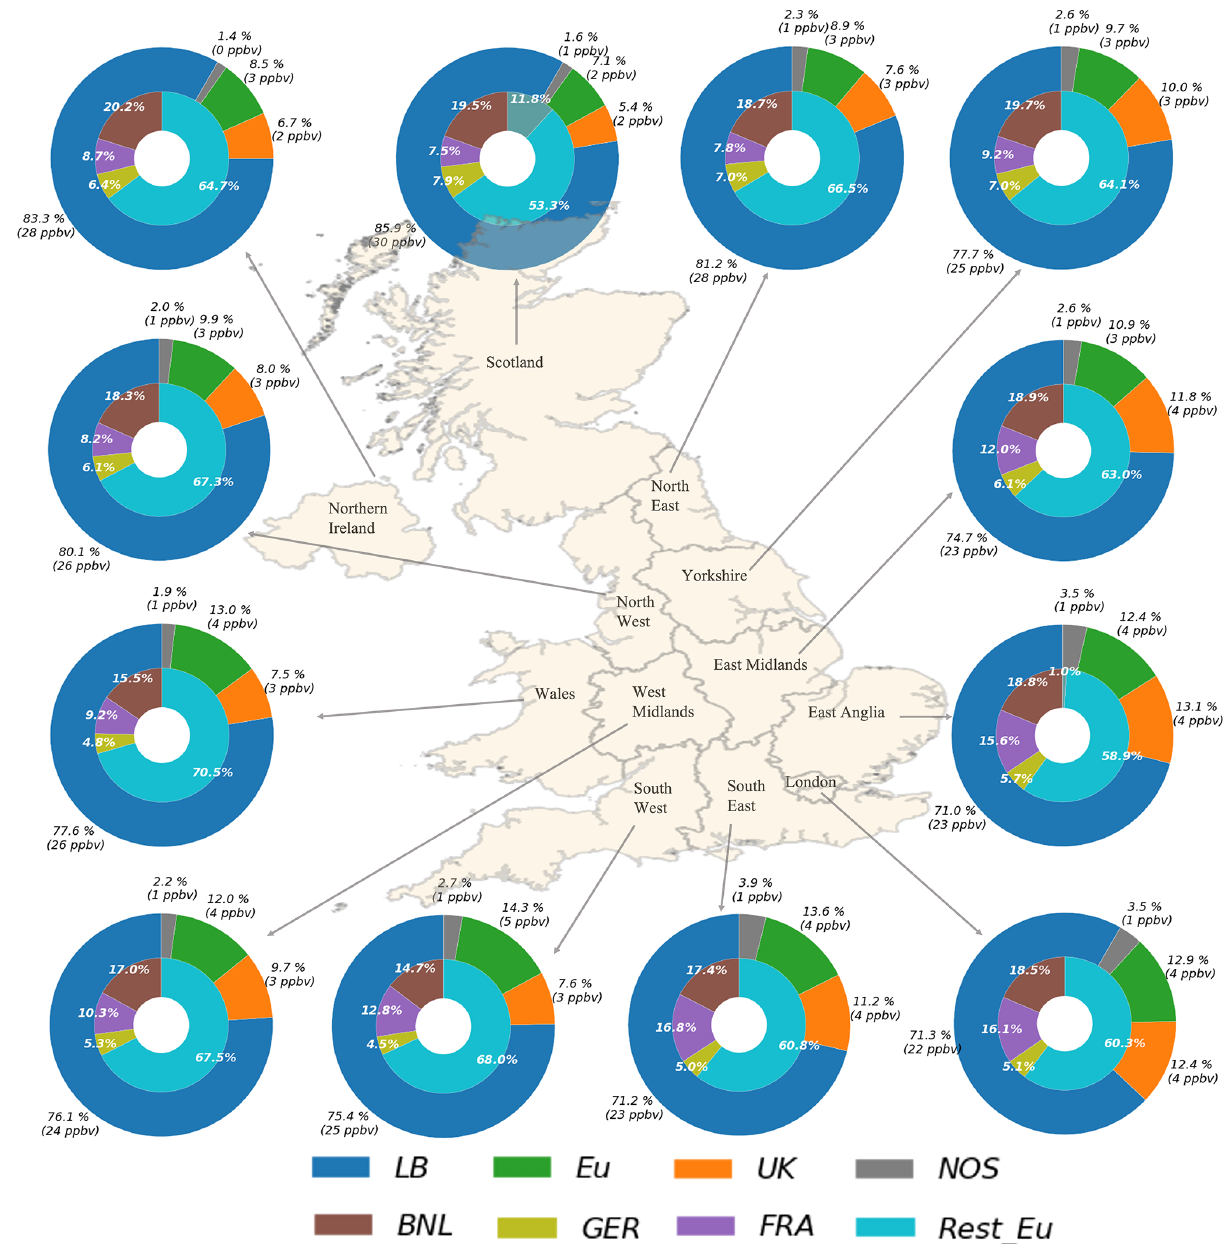
Figure 9. Simulated contributions to the mean O 3 mixing ratios in May 2015 over 12 receptors regions in the UK. The outer circle de- picts the contributions from LB, the UK, the Eu super-region (Eu), and the NOS. The inner circle breaks down the contribution from the Eu super-region into four sub-regions: Benelux (BNL), France (FRA), Germany (GER), and the rest of Europe (Rest_Eu). Note that the values correspond to the contributions from anthropogenic sources only, with the exception of the LB contributions, which include O 3 of stratospheric